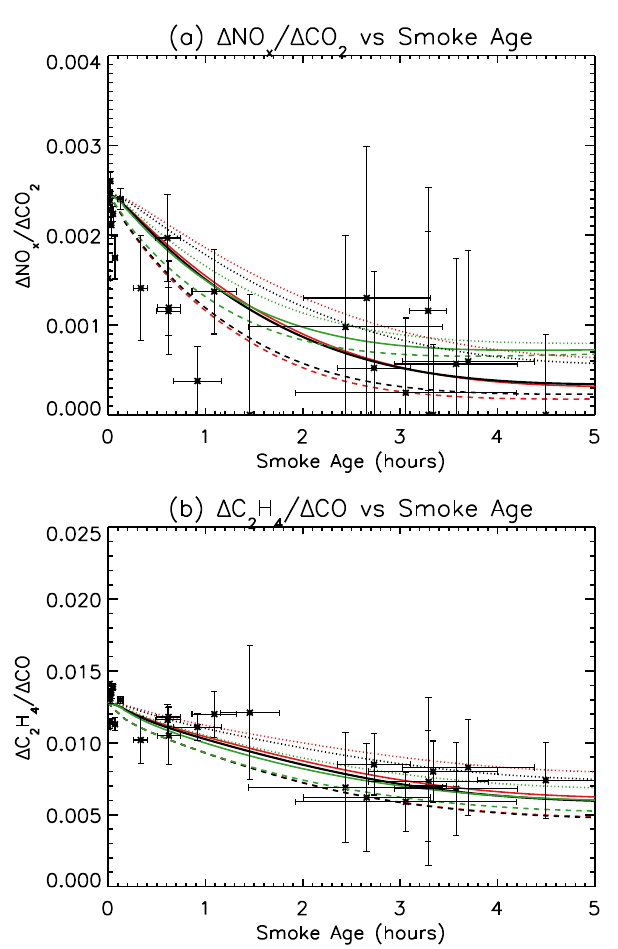
Figure 6. (a) NO x enhancement ratio (EnR; molmol − 1 ) to CO 2 vs. estimated smoke age when the chemistry of the unidentified SVOCs is not included in the model. (b) EnR of C 2 H 4 to CO vs. es- timated smoke age. Asterisks are the measured mixing ratios, with the horizontal error bars showing the uncertainty in the estimated age and the vertical error bars showing the uncertainty in the mea- surement. Red, black, and green are ASP results for the slow, best- fit (medium), and fast plume dilution rates. Dashed lines are for above-plume photolysis rates, while solid lines are for the middle of the plume, and dotted lines are for the bottom of the plume (see the legend in Fig. 4).